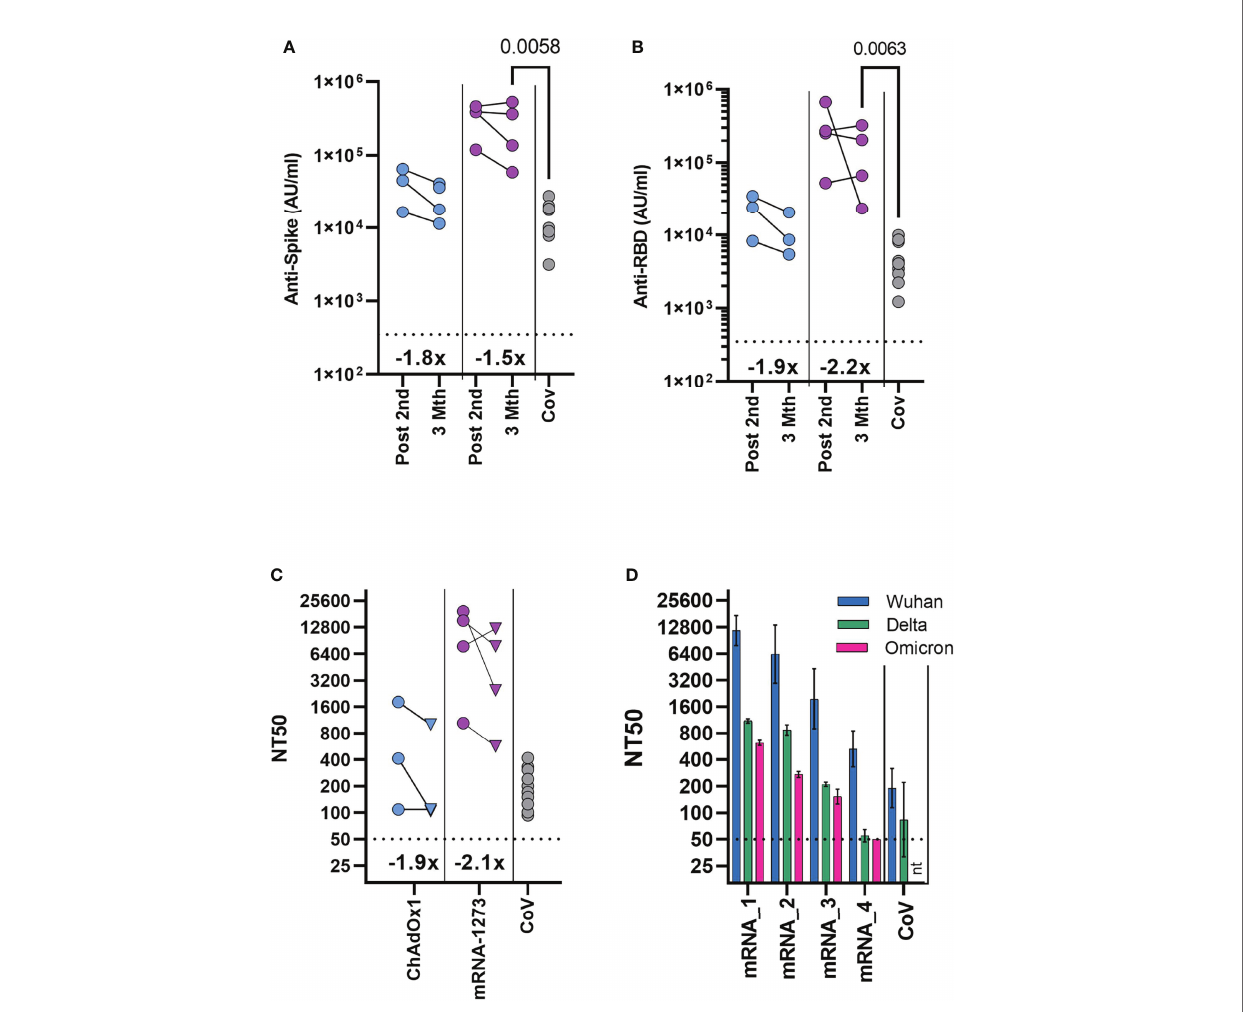
FIGURE 4 | Durability of antibody response and neutralisation of the Omicron variant 3 months after second dose. Antibody levels to Spike (A) and RBD (B) measured by MSD assay in previously seronegative adolescents receiving two COVID-19 vaccinations (ChAdOx1 – (n = 3), mRNA-1273 – (n = 4), either following second dose (Post 2 nd ), or three months after second dose (3 Mth). Antibody levels 2-4 months following natural SARS-CoV-2 infection [CoV, (n = 10)] are shown for comparison. (C) Neutralising antibody titres quanti fi ed using HIV (SARS-CoV-2) pseudotypes bearing the Wuhan spike glycoprotein. Each point represents the mean of three replicates, circles indicate following second dose, triangle three months after second dose. (A – C) Inset show the fold change in geometric mean titre. (D) Neutralising antibody titres quanti fi ed three months after second dose in four mRNA-1273 vaccinated individuals using HIV (SARS-CoV-2) pseudotypes bearing either Wuhan, B.1.617.2 (Delta) or B.1.1.529 (Omicron) spike glycoprotein. mRNA1-4 indicate individual donors. Bars indicate mean (± geometric SD). Neutralisation titres 2-4 months following natural SARS-CoV-2 infection [CoV, (n=10)] are shown for comparison. Kruskal-Wallis test with Dunn ’ s multiple comparison